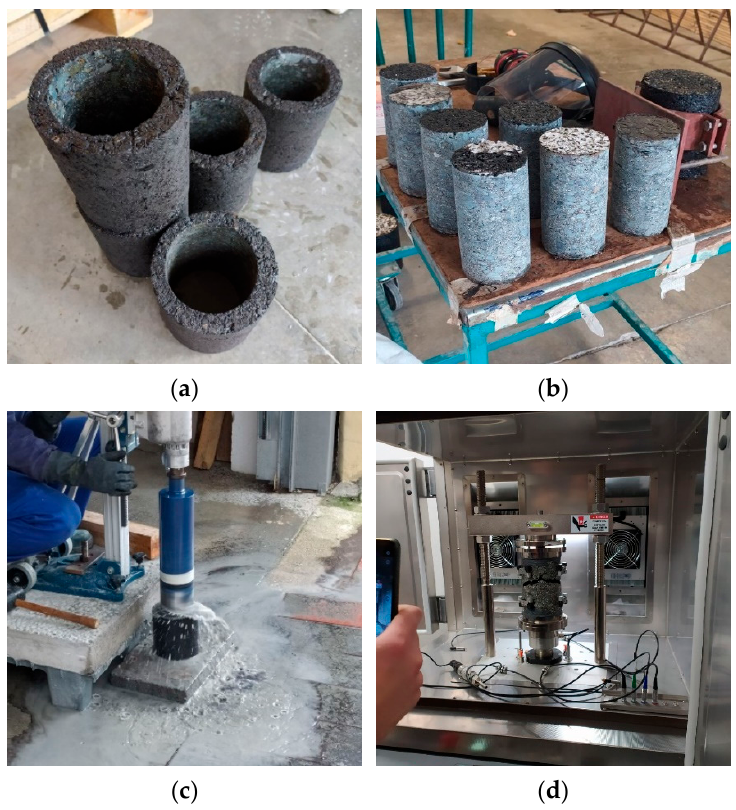
Figure 3. Preparation of asphalt specimens for fatigue testing: ( a ) cylindrical cutting of the specimens; ( b ) core of the specimens after cutting; ( c ) bonding of the specimens before testing; ( d ) uniaxial fatigue test of the specimens.